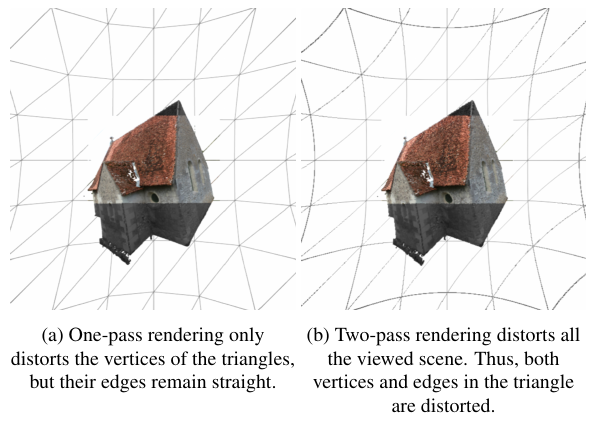
Figure 7. Comparison between one-pass and two-pass pipelines. A wireframe tessellated plane has been put in front of the viewed scene to showcase the two methods.